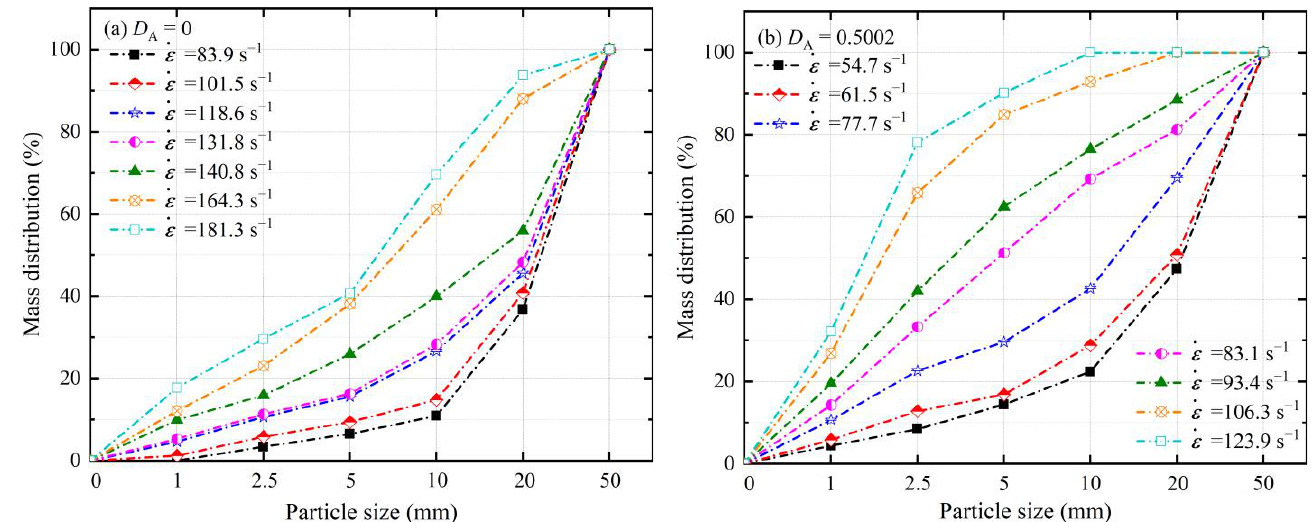
= 0 . 5002 D . Figure 14. The particle size distribution of specimens: ( a ) D = A A